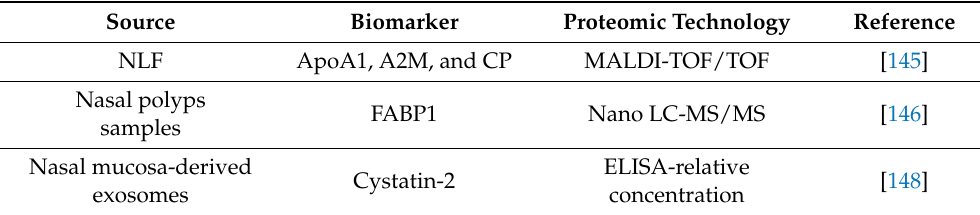
Table 5. A list of current proteins described in AERD by proteomic technologies.